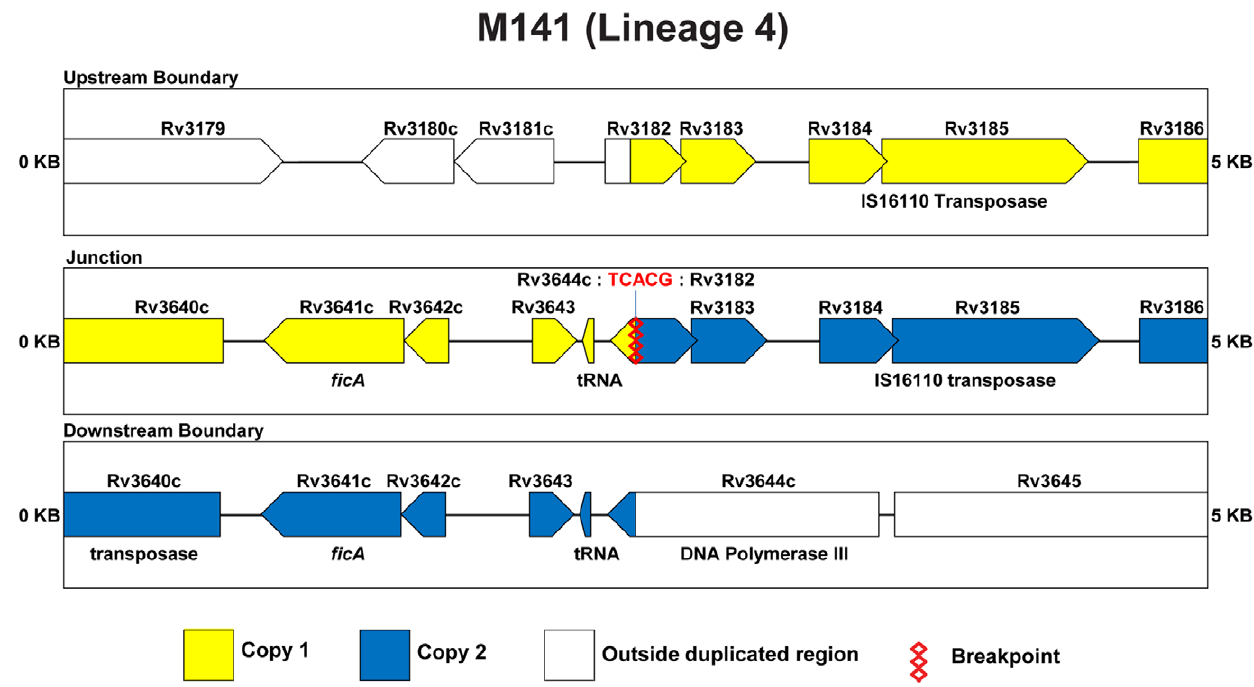
Figure 6. Schematic of duplication boundaries and junctions for M141. Color coding is identical to Figure 5.